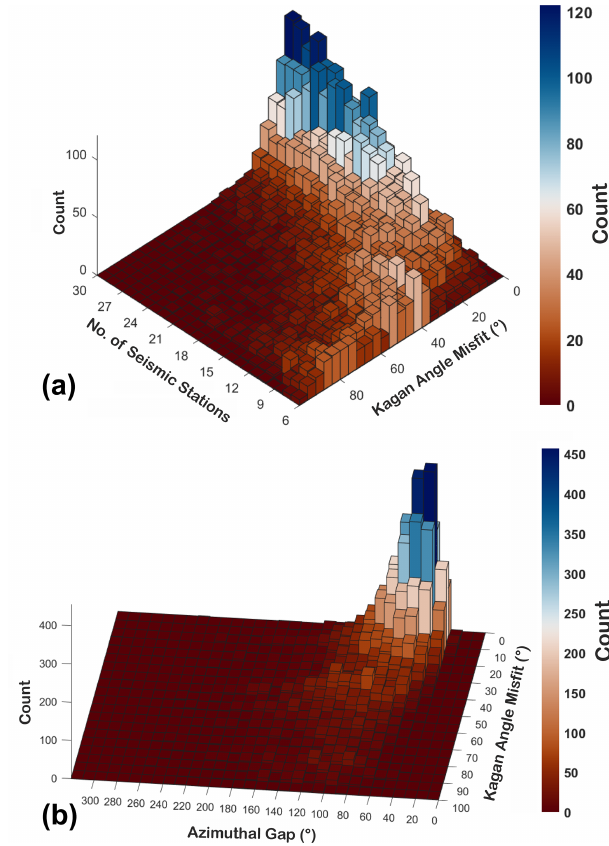
Figure 13. Three-dimensional histograms of the test results in terms of the number of stations (a) , azimuthal gap (b) , and KA misfit. The simulations were carried out with a free network